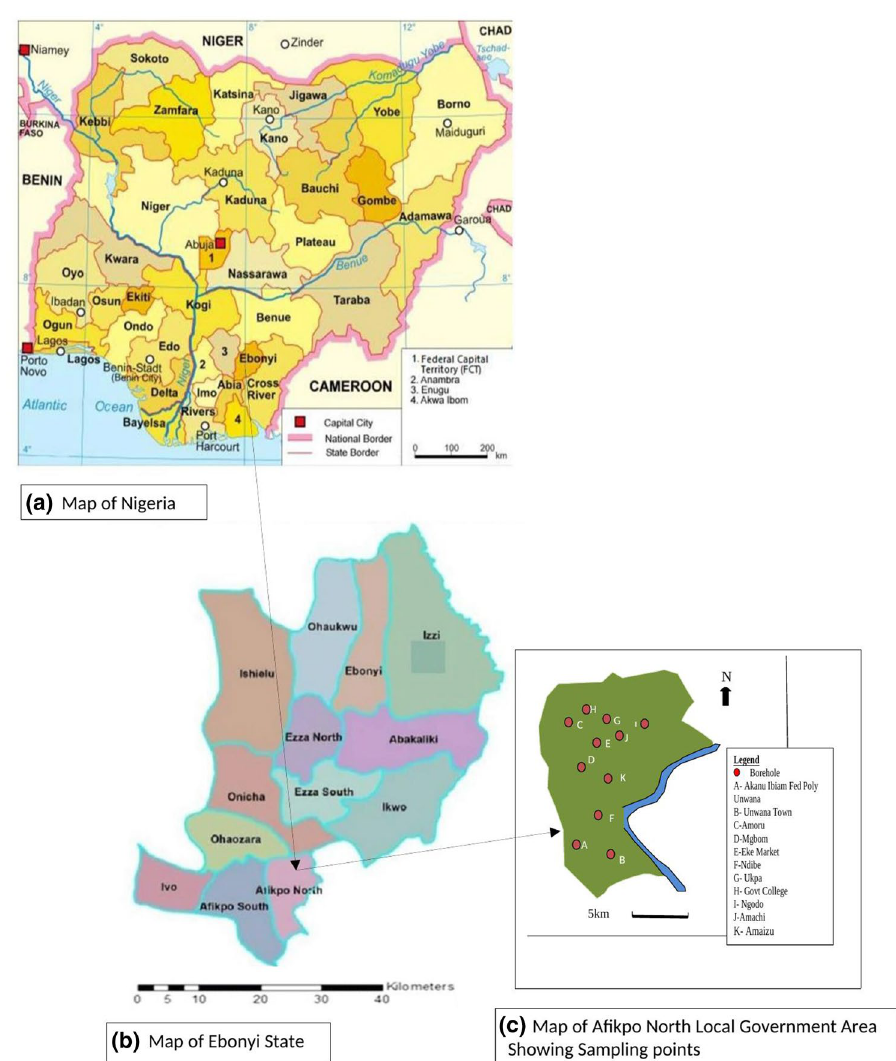
Fig. 1 Maps locating the study area and sampling